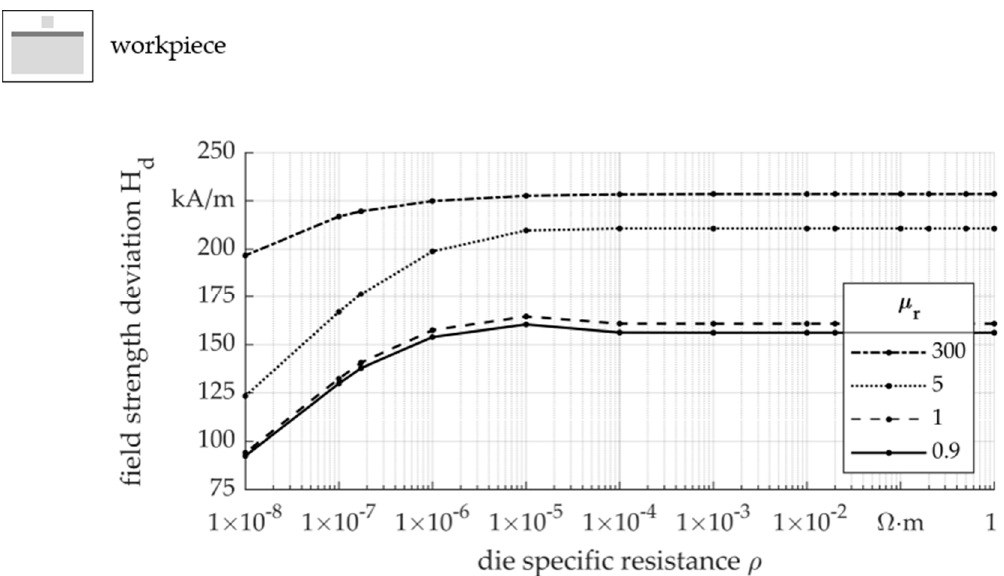
Figure 13. Field strength deviation H d (standard deviation of the magnetic field strength) in the workpiece in respect of the specific resistance of the die material.